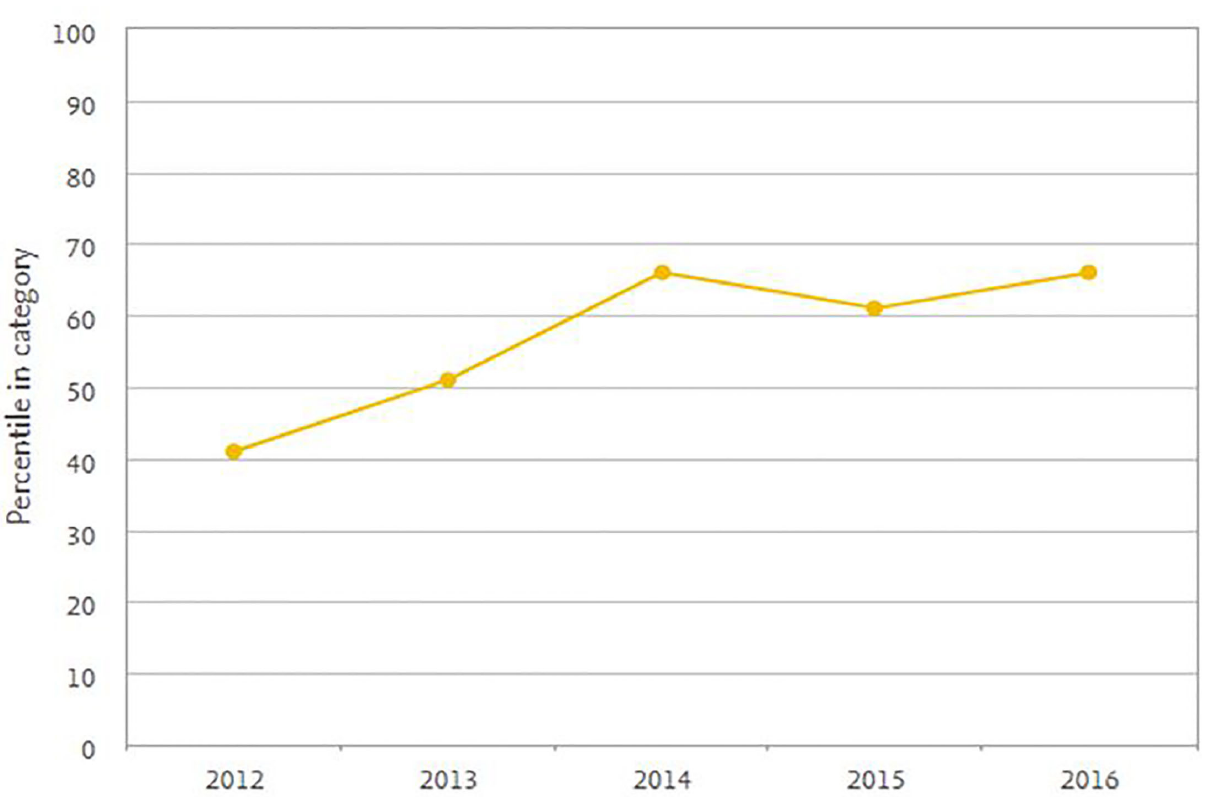
Figure 2. Percentile trend compared with 75 journals in emergency medicine in Scopus CiteScore for Western Journal of Emergency Medicine (higher is